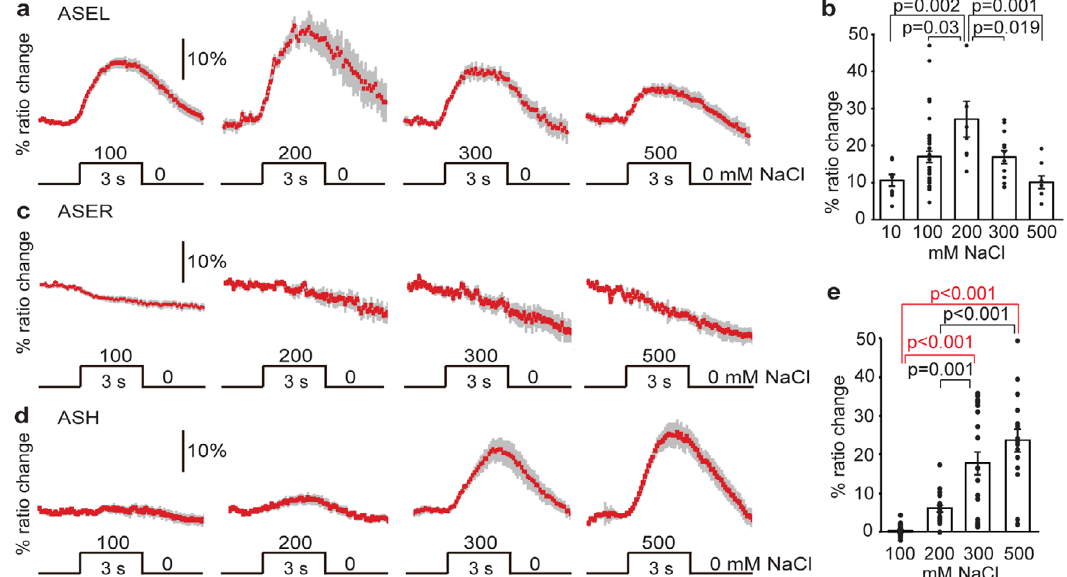
Fig. 1 Ca 2 + responses of ASEL, ASER, and ASH neurons to brief NaCl exposure. Animals were exposed for 3 s to different concentrations of NaCl from a baseline of 0 mM. a Average Ca 2 + transient (±SEM in gray) in ASEL in response to 100 – 500 mM NaCl; 100 mM: n = 37, 200 mM: n = 9, 300 mM: n = 15, 500 mM: n = 8 animals. b Average maximum ratio changes (±SEM) in ASEL: responses to 10 ( n = 10 animals), 100 ( n = 37), 300 (n = 15) and 500 ( n = 8) mM were signi fi cantly different from the response to 200 mM ( n = 9). c Average Ca 2 + transients (±SEM in gray) in ASER in response to 100 – 500 mM NaCl; 100 mM: n = 30, 200 mM: n = 5, 300 mM: n = 9, 500 mM: n = 4 animals. No statistically signi fi cant differences were observed ( p > 0.05). d Average Ca 2 + transients (±SEM) in ASH after exposure to 100 – 500 mM NaCl; 100 mM: n = 18, 200 mM: n = 18, 300 mM: n = 22, 500 mM: n = 19 animals. e Average maximum ratio changes (±SEM) in ASH: responses to 300 and 500 mM were signi fi cantly different from the responses to 100 and 200 mM. Traces indicate average percentage change in R / R o where R is the fl uorescence emission ratio and R o is the baseline fl uorescence emission ratio before exposure to NaCl. Individual data points have been indicated as dots. Statistically signi fi cant differences have been indicated (non-signi fi cant differences, p > 0.05, have not been indicated). Source data underlying this fi gure are available in Supplementary Data